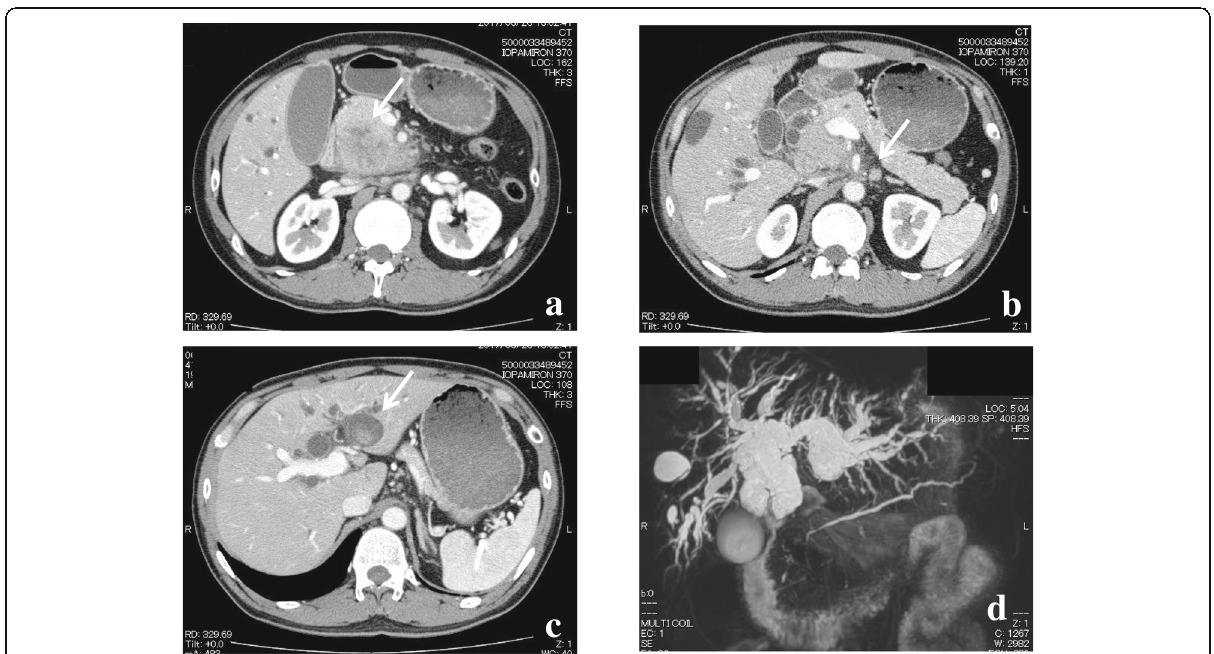
Fig. 1 a Dynamic abdominal computed tomography (CT) revealed a tumor suspected as a lymph node (maximum diameter, 45 mm) around the hepatoduodenal ligament with invasion to the common bile duct and the pancreatic head (arrow). b Para-aortic lymph node enlargement was shown on dynamic CT (arrow). c Cystic dilatation with intraductal tumor, which was suspected as intraductal papillary neoplasm of the bile duct, was identified at the proximal side of the biliary branch in segment 2 (B2) on dynamic CT (arrow). d Dilatation of the intrahepatic bile duct was shown on magnetic resonance